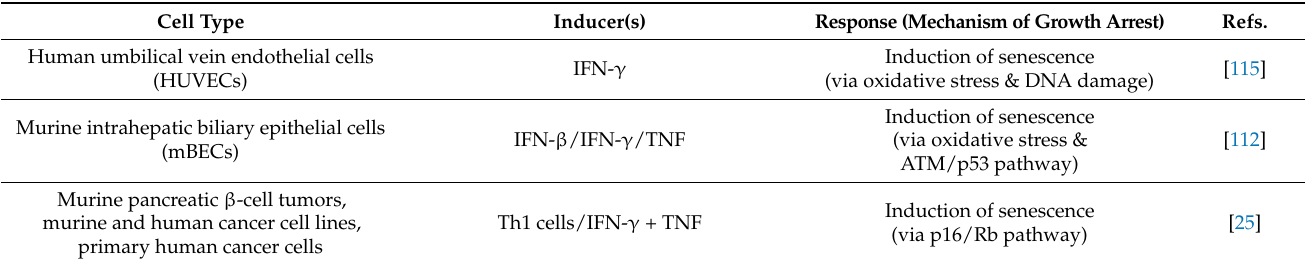
Table 1. Overview of model systems describing cytokine-mediated senescence